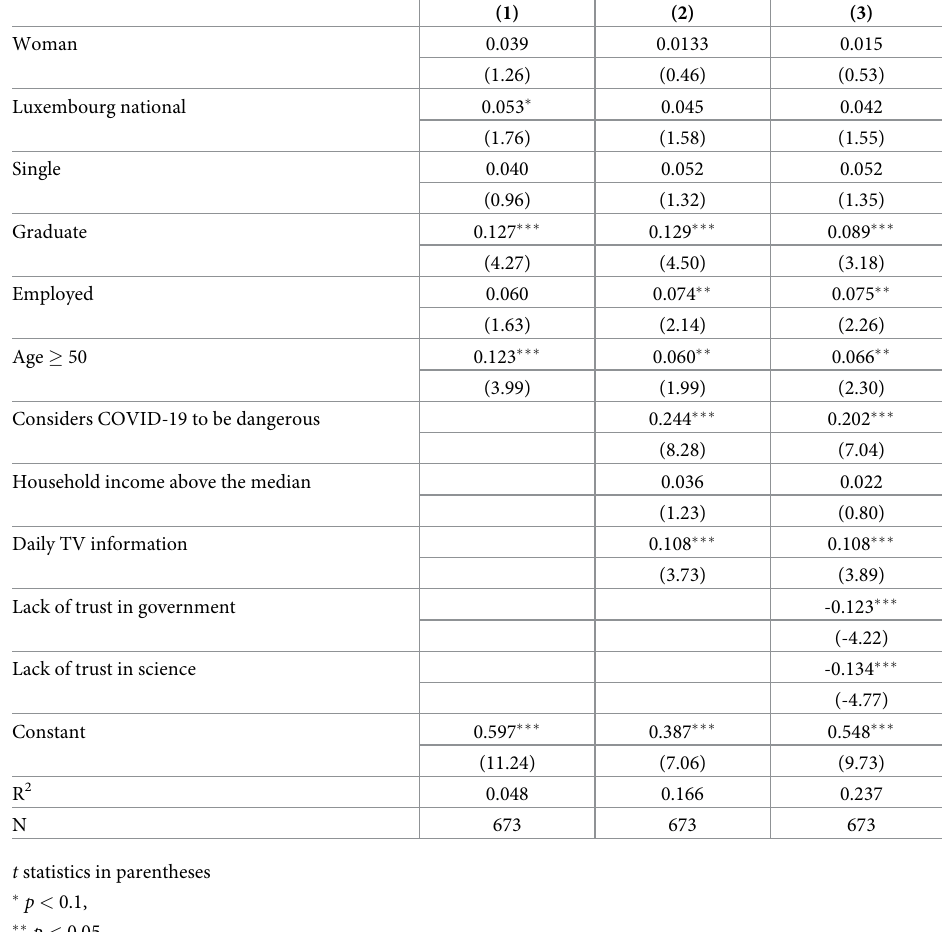
Table 2. Determinants of the willingness to be vaccinated: Linear